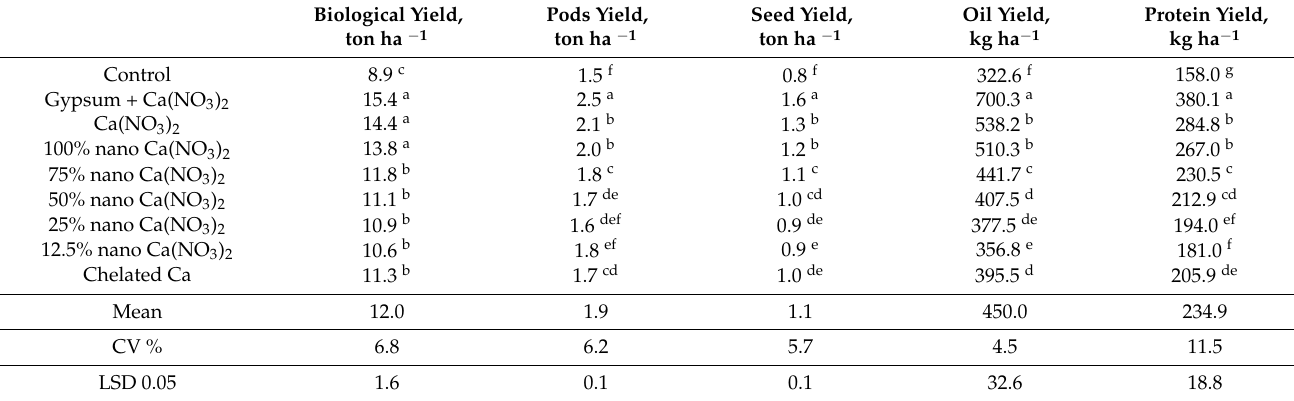
Table 7. Means of peanut yields and coefficient of variation (CV) tested under calcium treatments in the field experiments in Wadi El-Natroon, Egypt (combined data of the 2015 and 2016